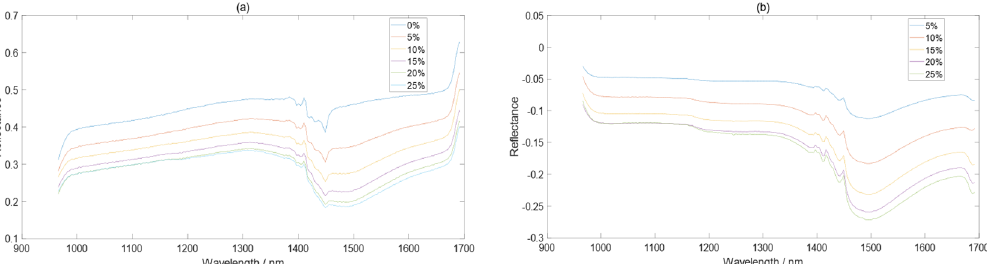
Figure 3. ( a ) Average spectral reflectance of soil samples with moisture contents of 0% (dry soil), 5%, 10%, 15%, 20%, and 25%; ( b ) the difference spectra of the wet soil samples with water contents of 5%, 10%, 15%, 20%, and 25% and the dry soil sample.